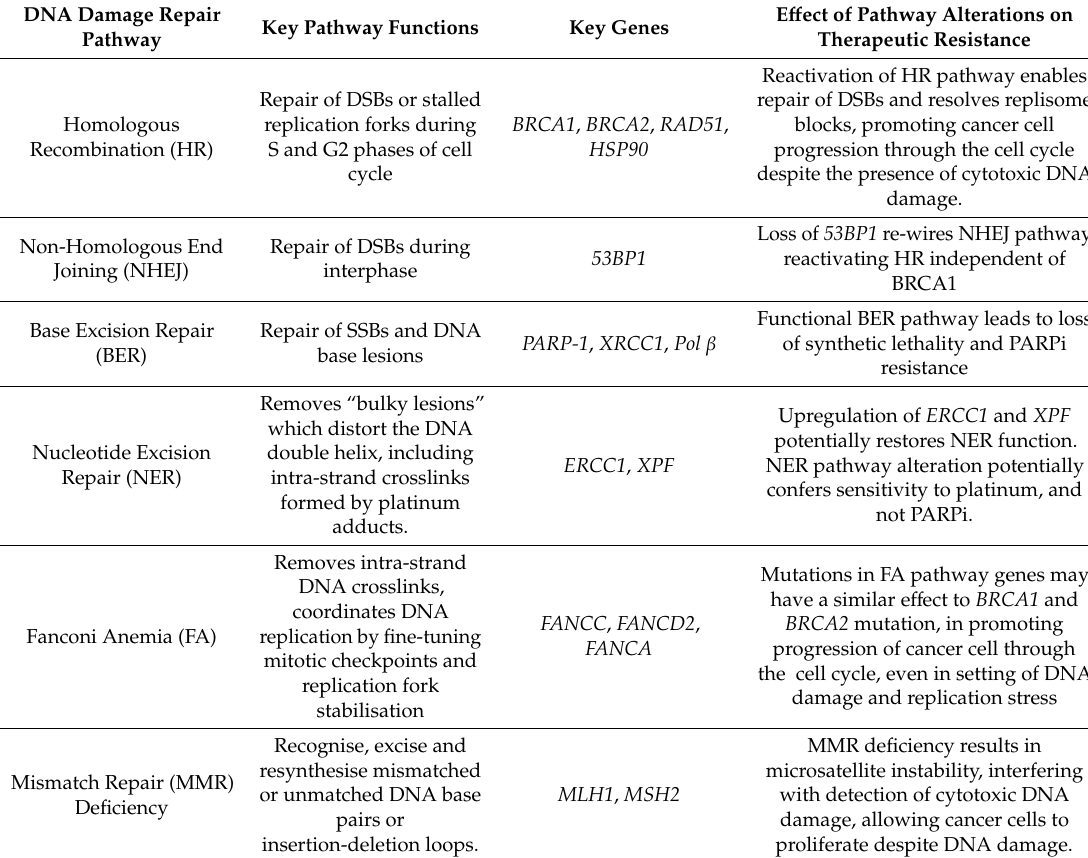
Table 2. Contribution of DNA Damage Repair pathway alterations to Platinum and PARPi